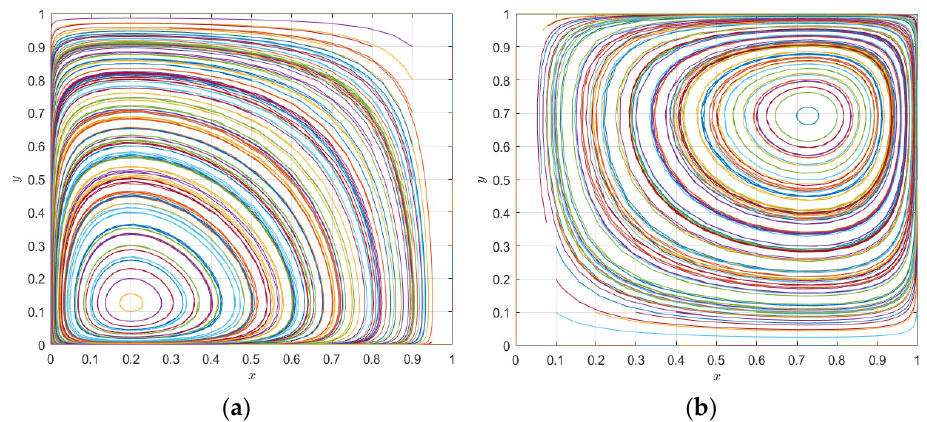
Figure 10. Evolution paths of pharmaceutical enterprises ( a ) and 3PL enterprises ( b ) under the static premium and penalty mechanism.